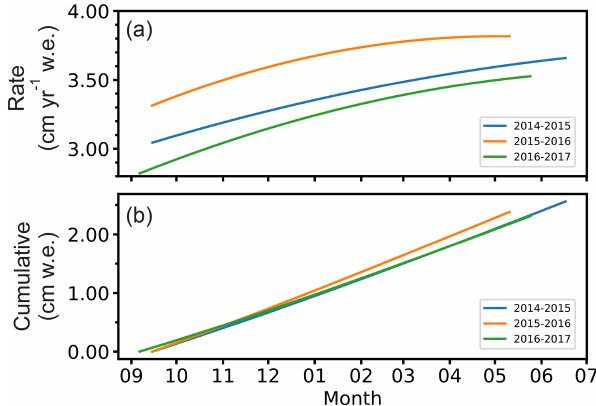
Figure 6. Basal meltwater generation at the 33km site: (a) instan- taneous basal melt rate in water equivalent over the winter during 3 different years; (b) cumulative meltwater generation over the win- ter period during 3